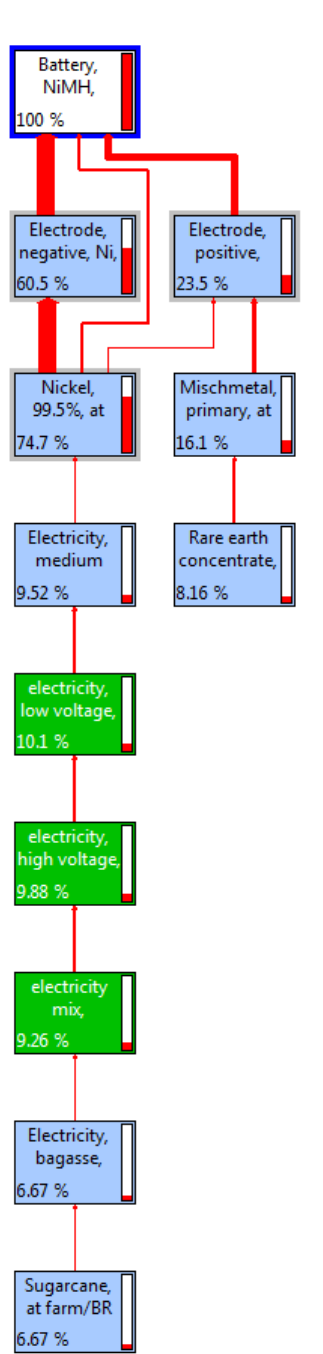
Figure 5. Material flow sheet for 1 kg of NiMH battery